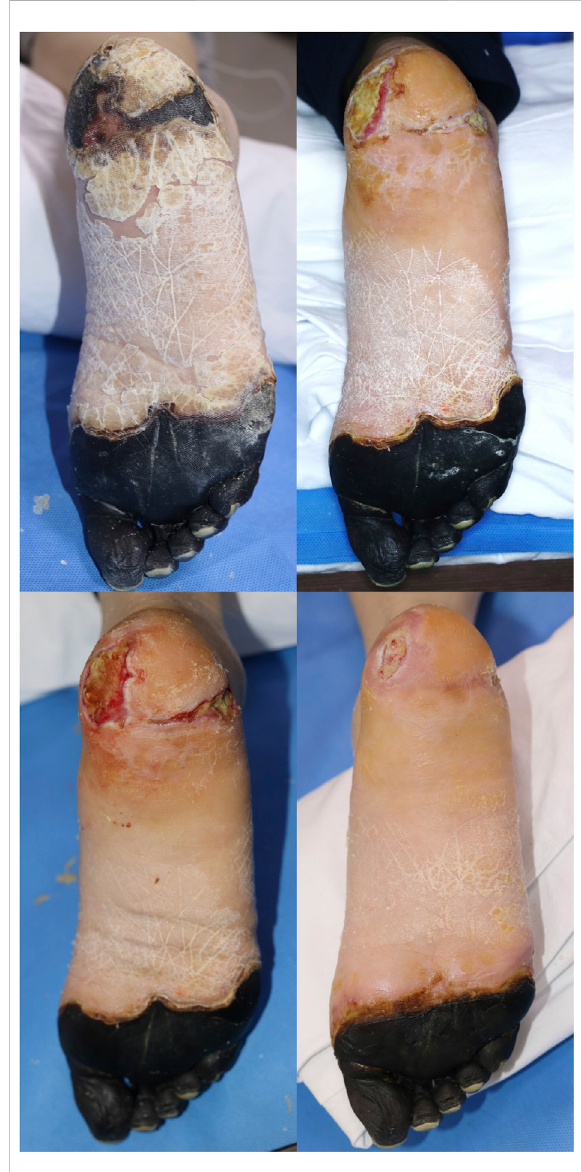
FIGURE 6 Case 2. A 53-year-old female with no medical